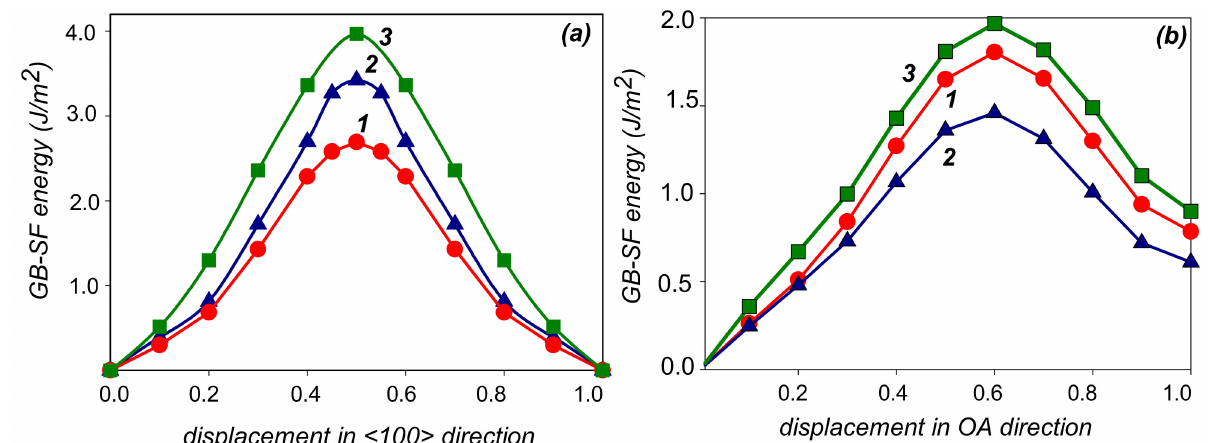
Figure 4. Ab initio GB–SF energy without relaxation for shear along O–O1 <100> ( a ) and O–A ( b ) directions in the plane of the Σ 5{013} <100> GB. Curves 1, 2, and 3 correspond to pure Al, Al–Zn alloy, and Al–Mg alloy, respectively.